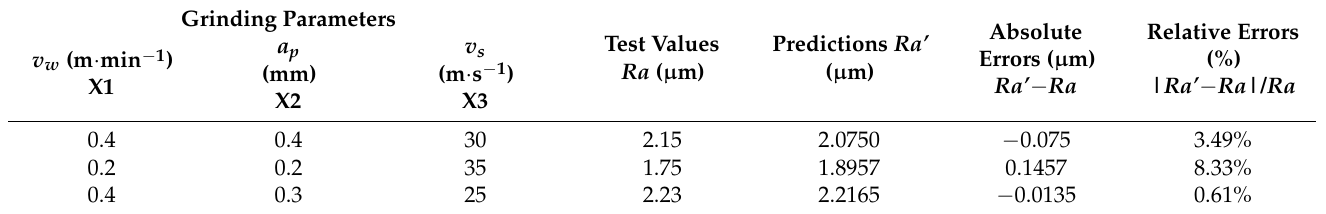
Table 8. Test values of grind-hardening compared with the predictions of BP neural network.